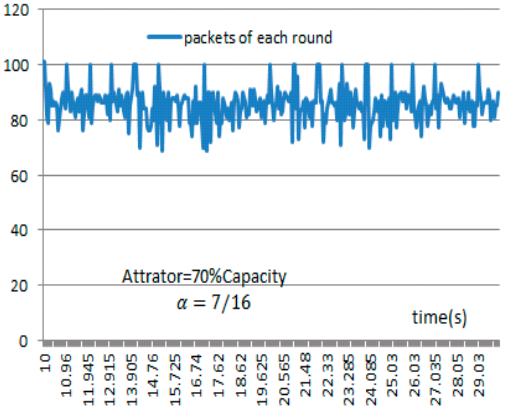
Figure 25. Comparison of the throughput under CAR/IMG. Figure 26. IMG packets of each Figure 26. IMG packets of each round. Table 5. Packets arriving to server statistics for the experiment in different Attractor.